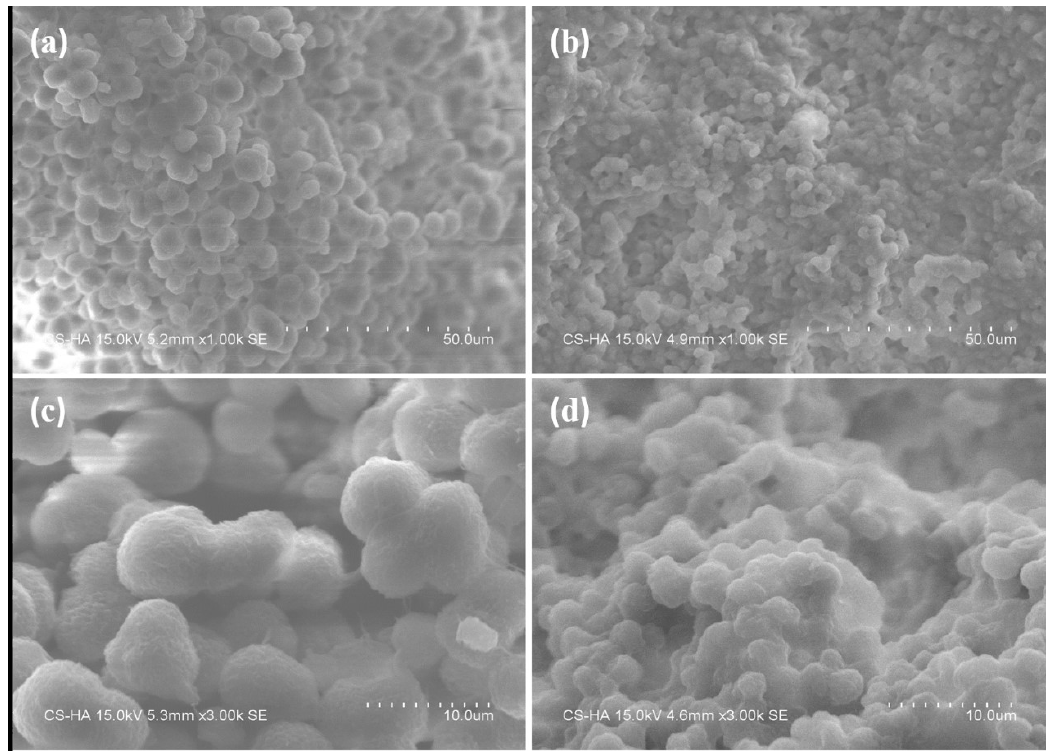
Figure 2. Scanning electron microscope (SEM) images of MPP and TMPP modifiers after hydrolysis. (( a ) MPP powder, 1000 times, ( b ) TMPP powder, 1000 times, ( c ) MPP powders, 3000 times, ( d ) TMPP powder, 3000 times).